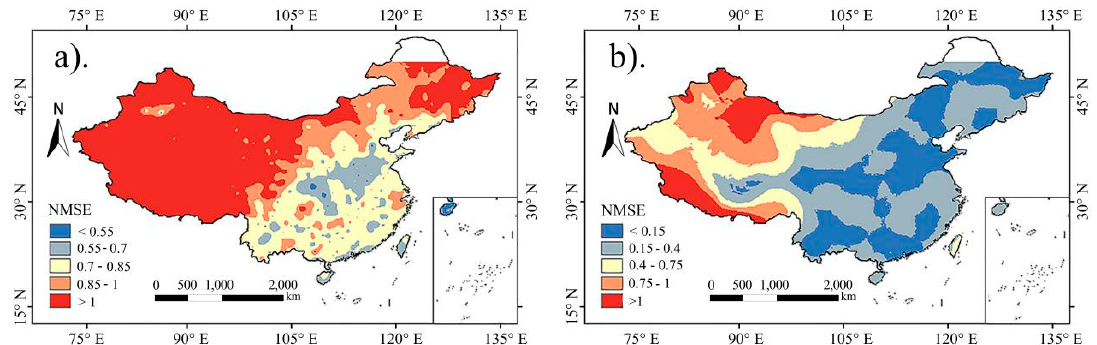
Figure 4. Spatial distribution of R, at the daily ( a ) and monthly ( b ) scale of the 3B42V7 data in mainland China.